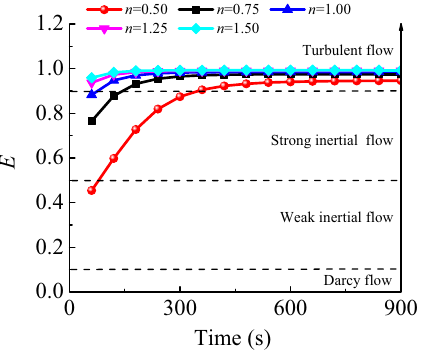
Figure 17. History of E at monitoring point A 3 under different values of